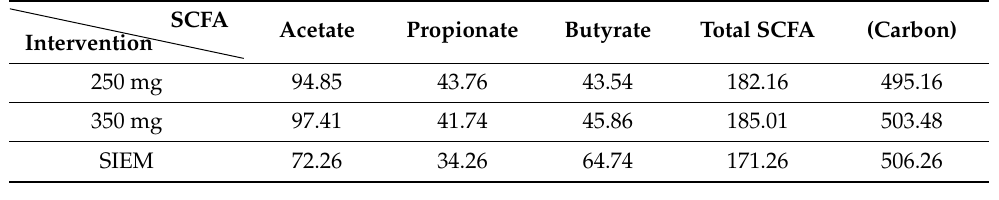
Table 1. Cumulative production of acetate, propionate, butyrate, total short-chain fatty acids (SCFA), and the amount of carbon present in these metabolites after 72 h of continuous supplementation with 250 or 350 mg Citrus Fruit Extract versus control (standard ileal efflux medium (SIEM)).